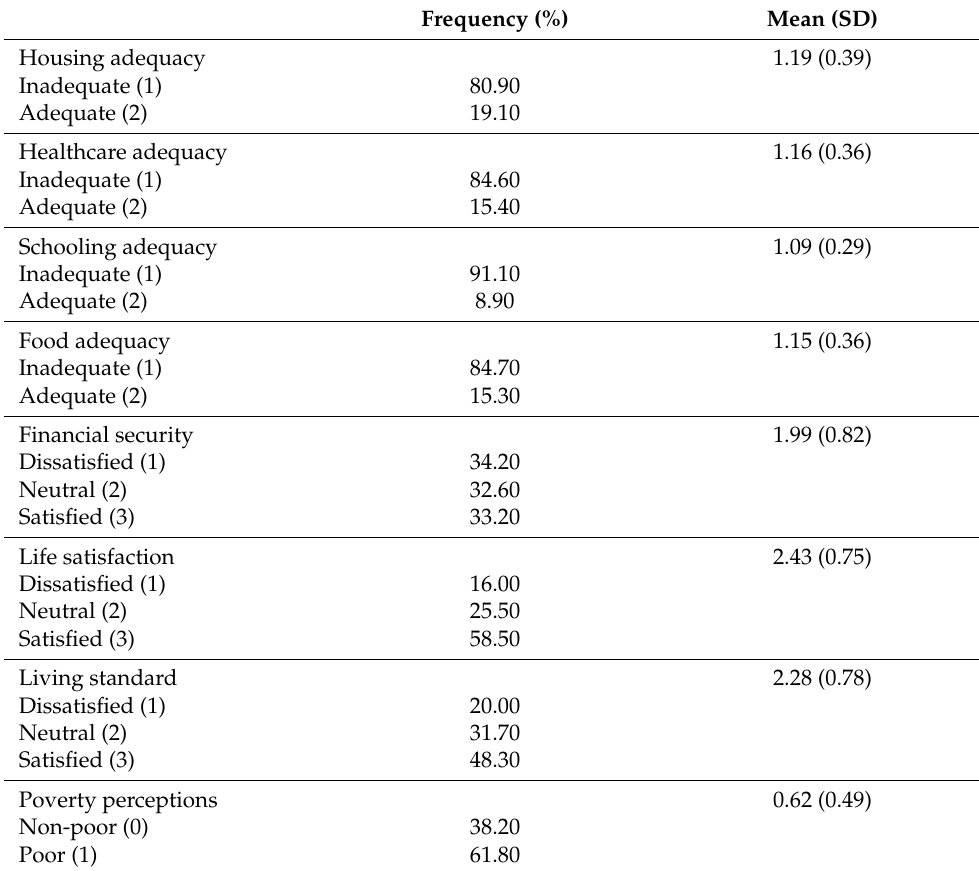
Table 1. Descriptive statistics of the household adequacy levels and satisfaction measures of the sample (n =